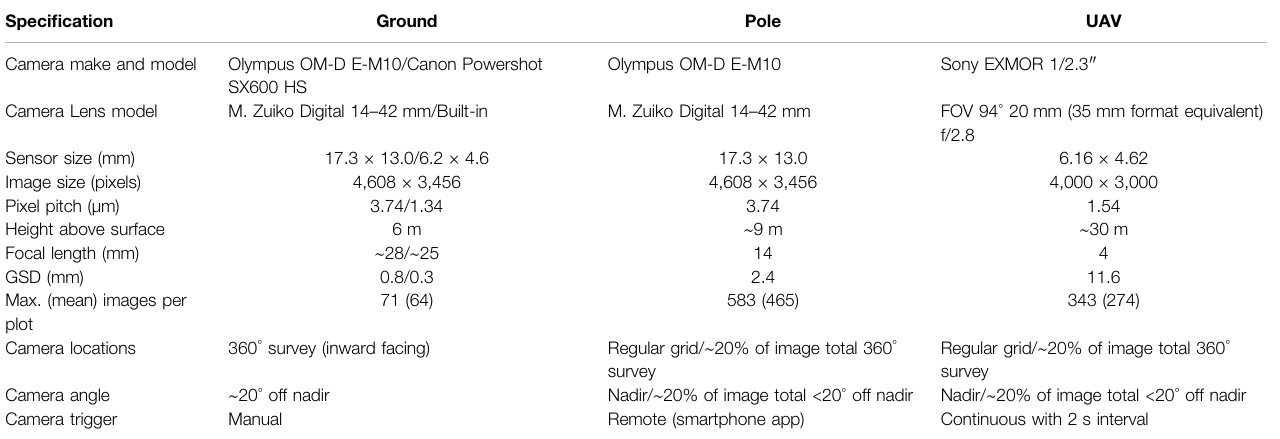
TABLE 1 | Details of cameras used and survey design for SfM data collection.